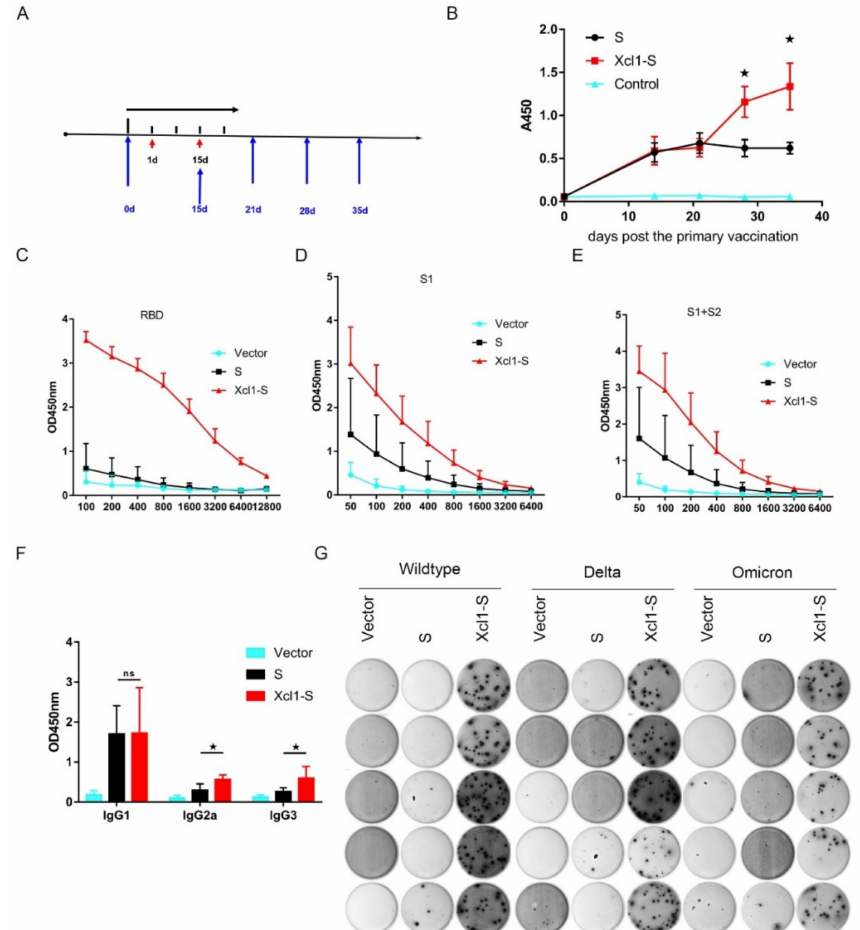
Figure 3. Xcl1-S vaccination elicited a significant increase in humoral immune responses. ( A , B ) C57BL/6 mice were immunized on days 0 and 14 with 25 µ g of the Xcl1-S, S or pVAX1 plasmid. Mouse serum with a 1:100 dilution for IgG ELISA assay were collected at the indicated times. The data shown here represent OD450 nm values (means ± SEM) for each group of mice. ( C – E ) Mouse serum was collected 21 days after the second vaccination and were sequentially diluted at different concentrations for IgGs against the RBD, S1 and S1 + S2 ECD of the S protein using ELISA. Data are means ± SEM. ( F ) The IgG1, IgG2a and IgG3 isotypes of anti-S were examined in serum with a 1:100 dilution collected after the second immunization. ( G ) 5 × 10 5 cells collected from bone marrow 16 weeks after the second vaccination were re-stimulated with wild-type, delta or omicron S protein for measuring S-specific long-lasting antibody-secreting cells. (cid:70) , p <